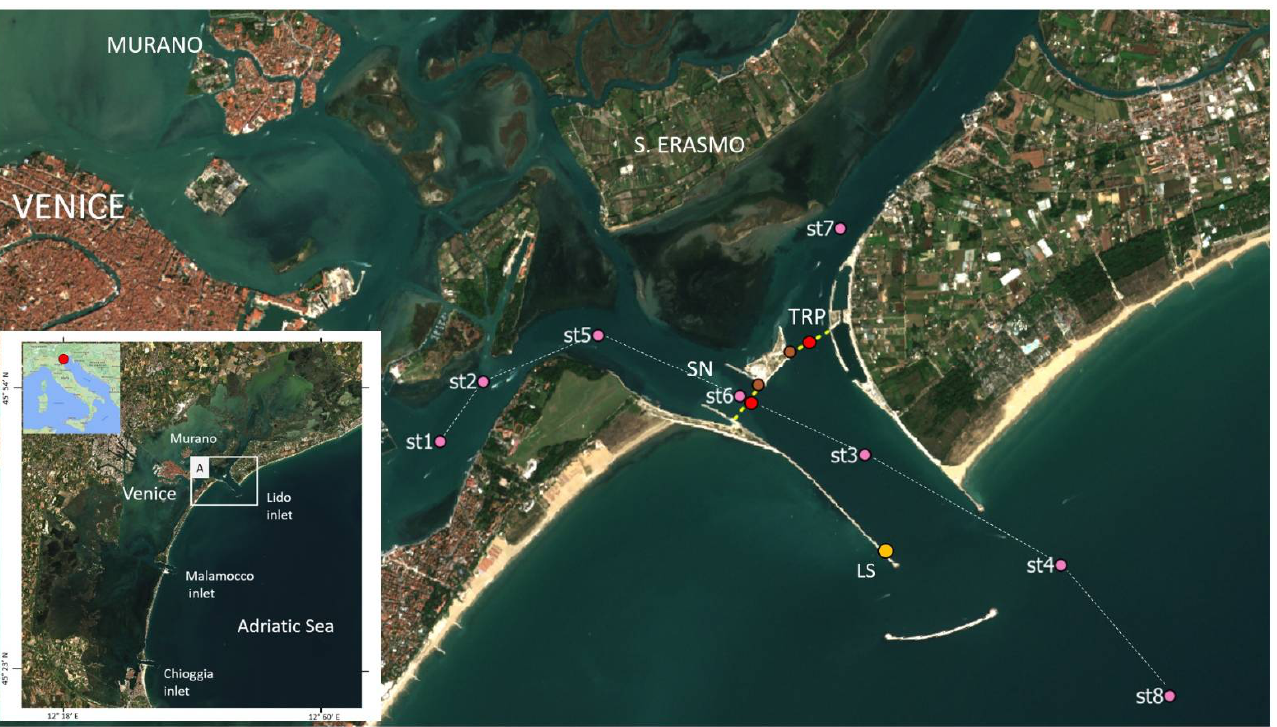
Figure 1. Copernicus Sentinel-2 true-colour composite of the study area at the two tidal channels (San Nicolò—SN, Treporti—TRP) originating from the Lido inlet in the Lagoon of Venice (Northern Adriatic Sea, Italy). In situ data were collected in the 8 sampling stations (pink dots) and the two boat-mounted ADCPs transects (yellow lines). The location of the fixed monitoring stations is also indicated: bottom-mounted ADCPs (red); tidal and meteo gauge Lido Sud station (LS, yellow); and OBS turbidimeters (brown).